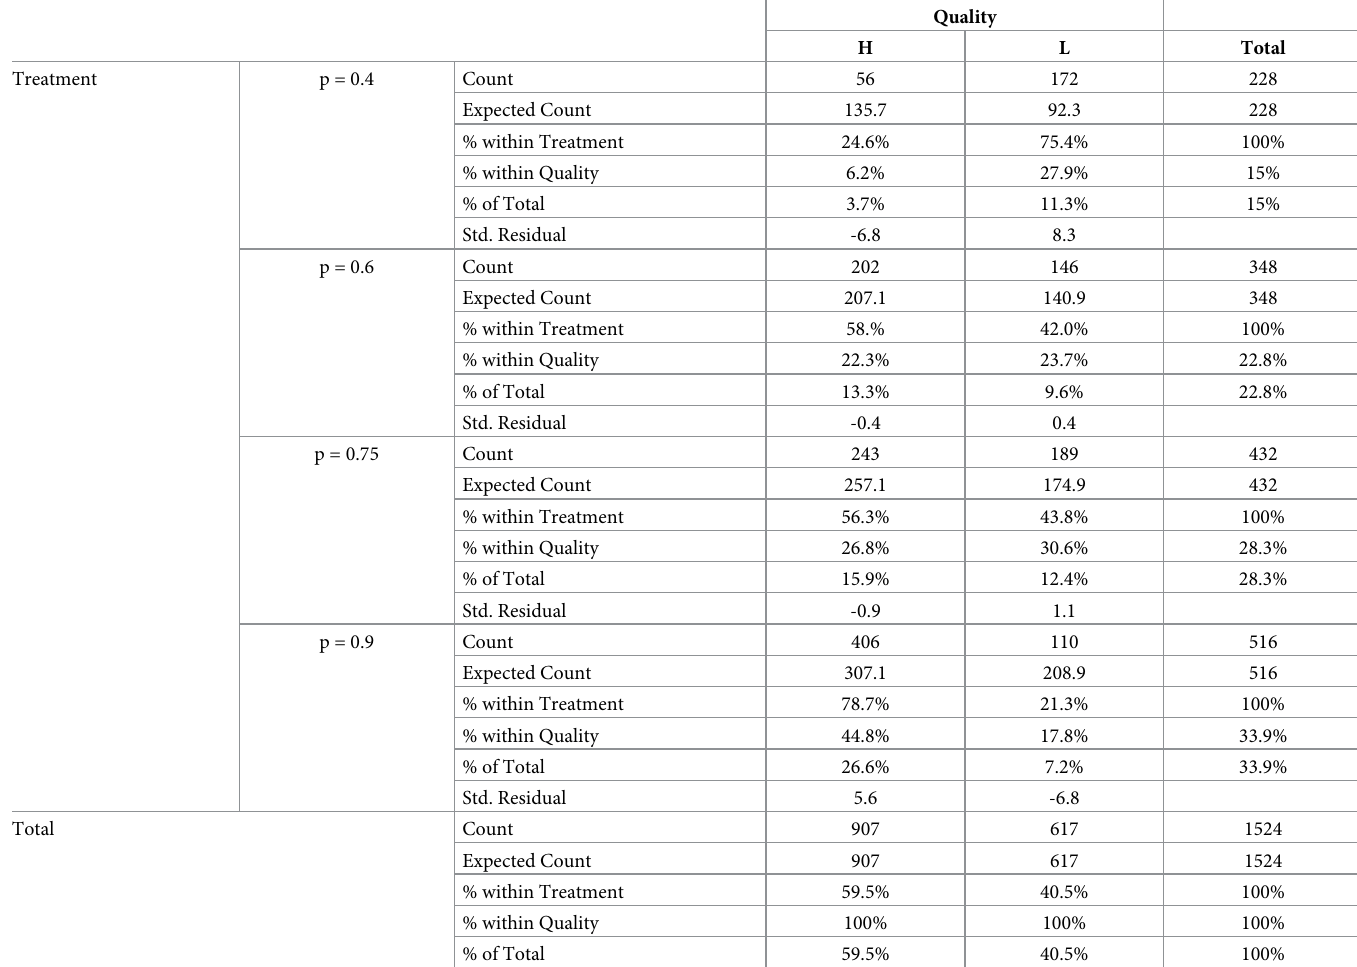
Table 2. Contingency table for chi-square test (SPSS output).